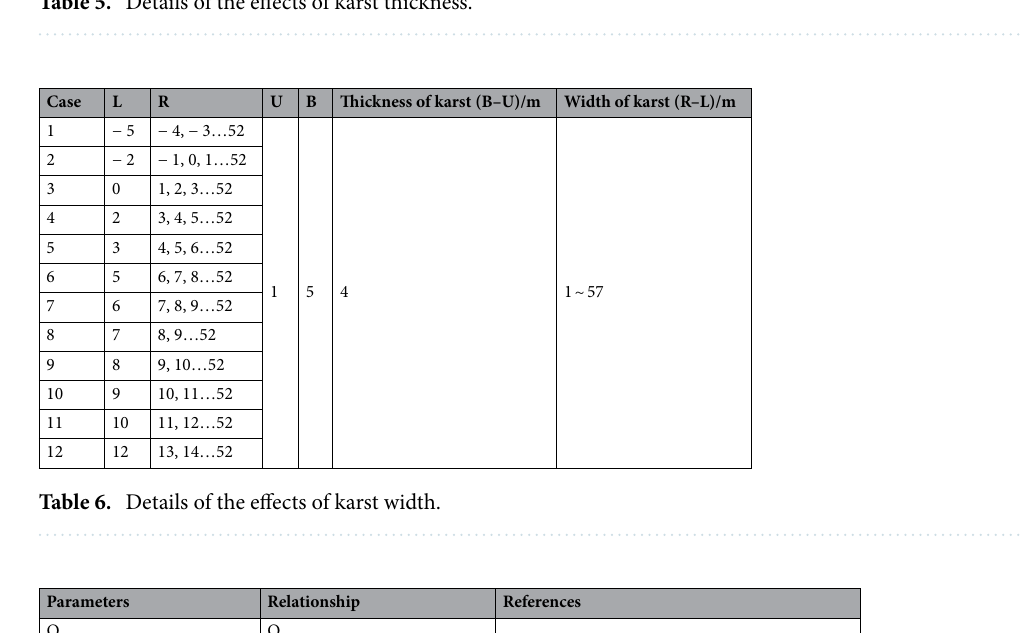
Table 5. Details of the effects of karst thickness.